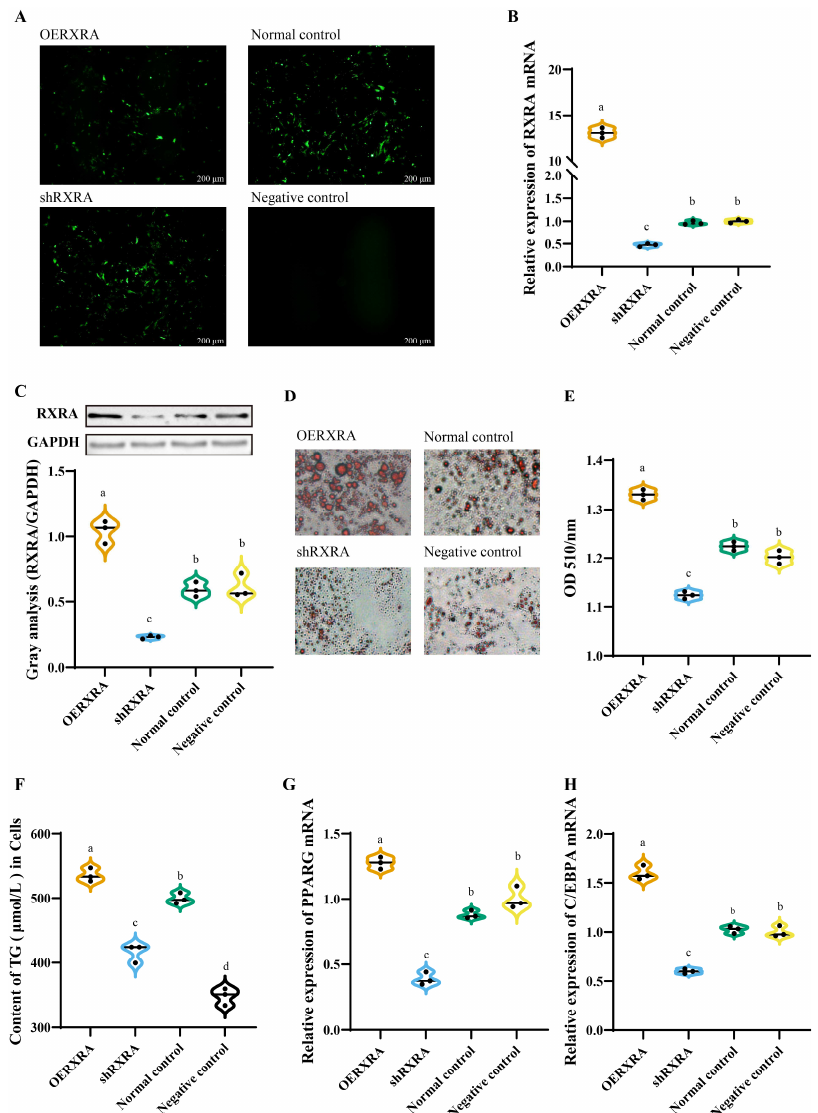
Figure 2. Effect of RXRA gene on the lipid metabolism of the DPACs. ( A ) The transfections of overexpression RXRA (OERXRA), knockdown RXRA (shRXRA), blank plasmid (Normal control), and culture medium (negative control) into the DPACs were observed under a fluorescence microscope. ( B ) The RXRA gene mRNA expression. ( C ) The indicated protein levels were detected by a Western blot analysis, and the relative fold change in RXRA/GAPDH determined by Western blotting was quantified through a grayscale scan. ( D ) Intracellular fat content. The images were taken under 200× magnification. ( E ) OD 510/nm: absorbance at 510 nm. ( F ) TG content in the DPACs. ( G ) The mRNA expression of PPARG gene. ( H ) The mRNA expression of C/EBPA gene. The data are reported as the mean ± SD on the basis of n = 3 independent experiments. a,b,c Significant differences are shown in superscript letters, with different letters representing significant differences ( p < 0.05). Original Western blot figures in Figure S2.